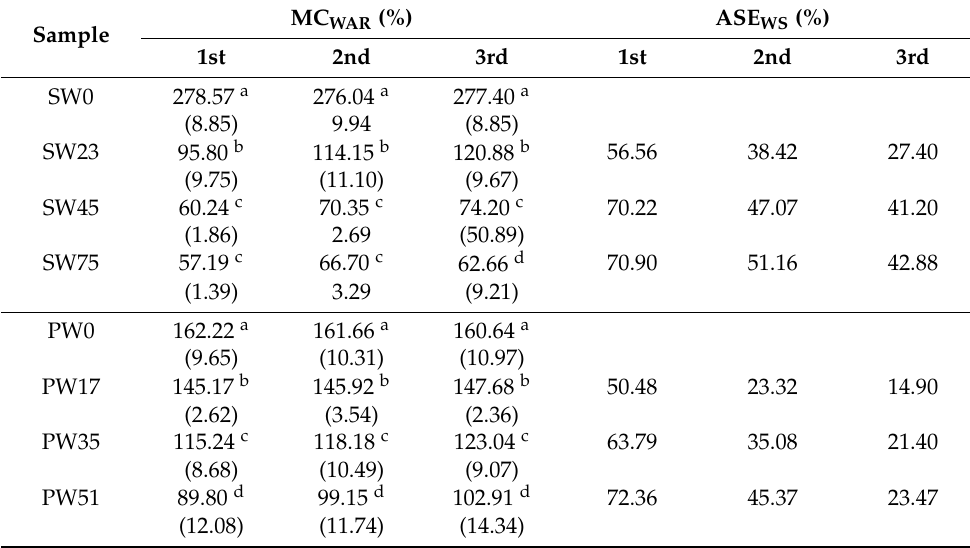
Table 4. Variation in MC WAR (fully water-saturated) and ASE WS of furfurylated and untreated poplar and Chinese fir with water